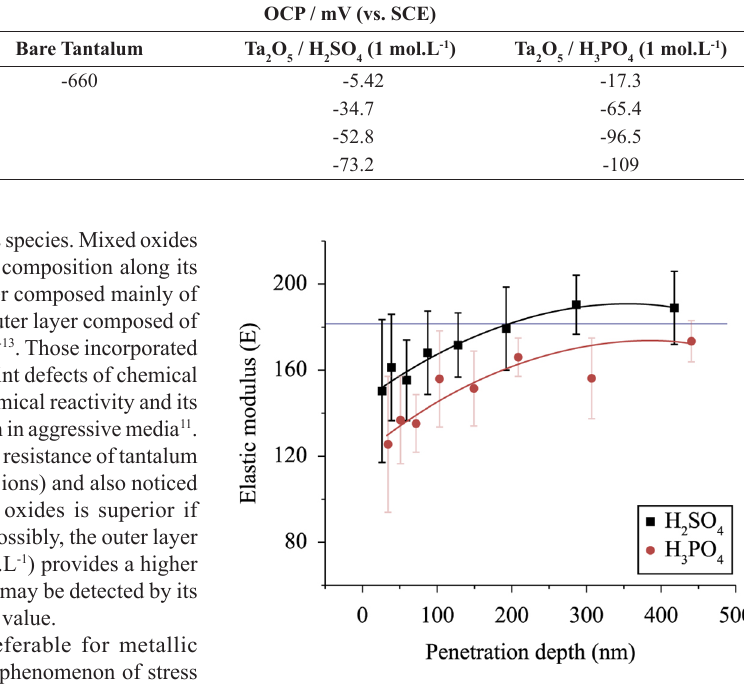
Figure 6. Elastic modulus as function of the penetration depth with a Berkovich tip in tantalum oxides obtained potentiostatically 20 V (1 h) in H SO and H PO (1 mol.L -1 ). The straight line represents 2 4 3 4 the metallic tantalum elastic modulus (186